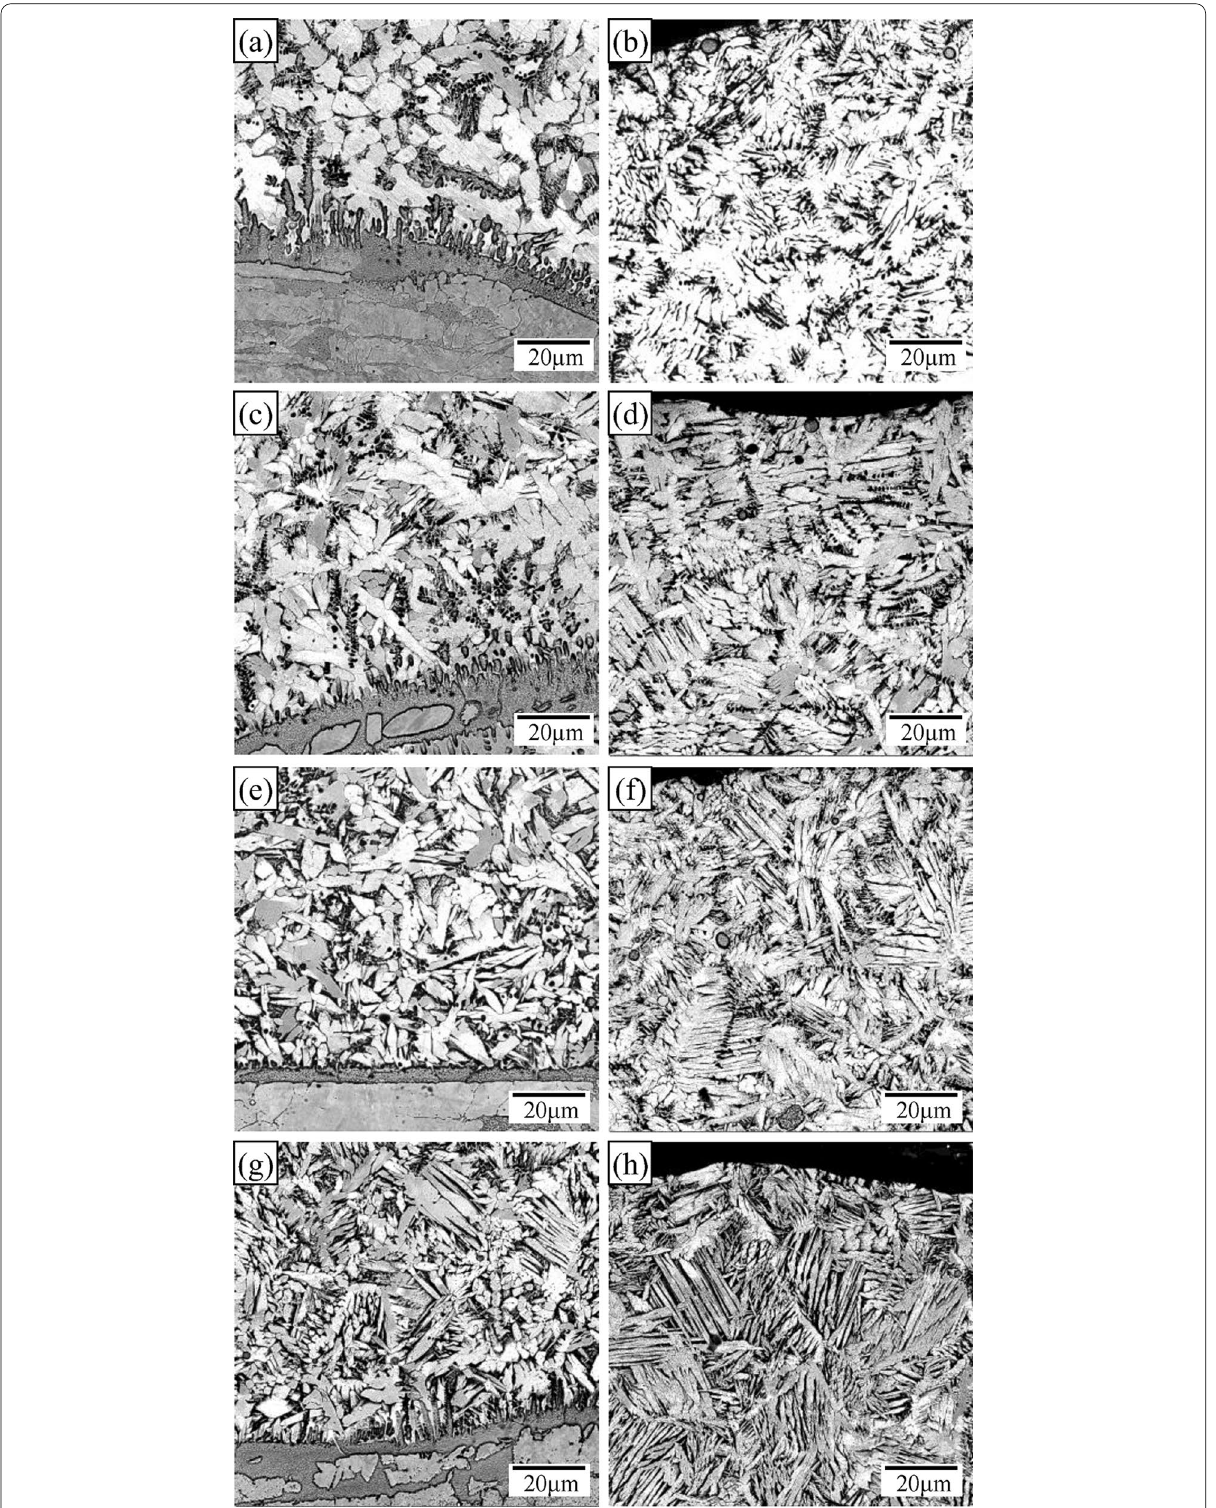
Figure 8 BSE images of laser depositing coatings: a , b zone 1 and zone 3 of S1; c , d zone 1 and zone 3 of S2; e , f zone 1 and zone 3 of S3; g , h zone 1 and zone 3 of